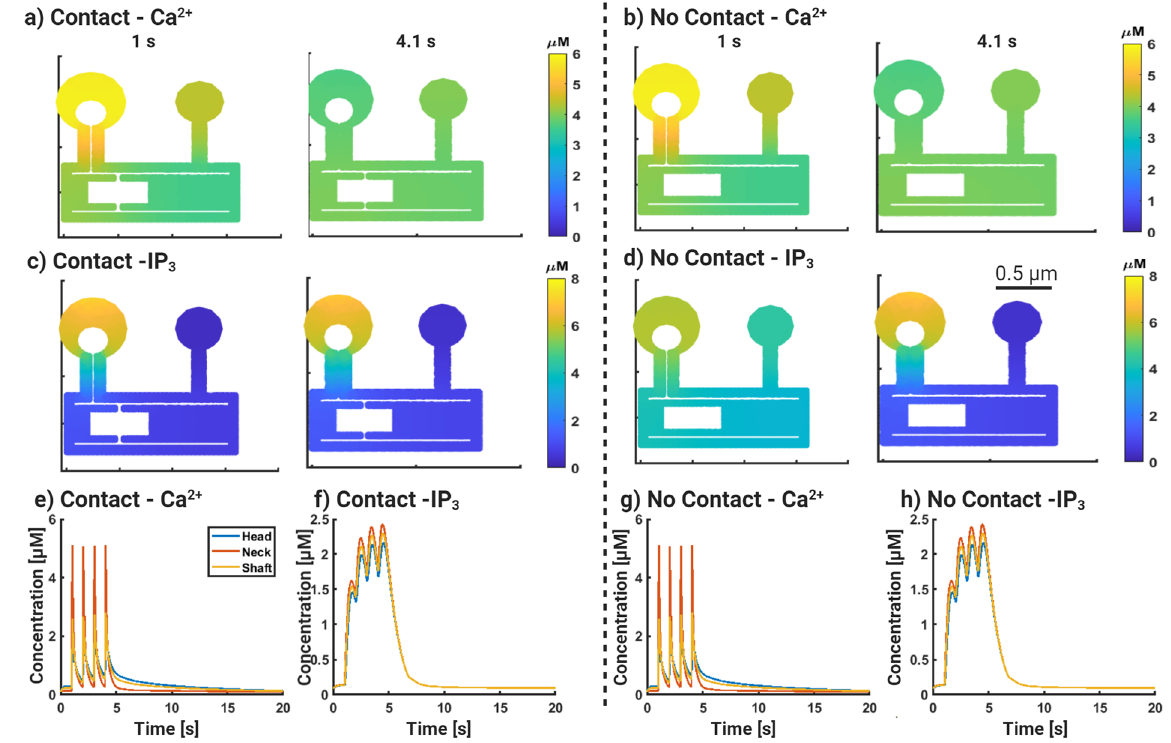
Fig. 2 Receptor-based simulations of glutamatergic signaling in spatial calcium model. Finite element simulations of dendritic spines including mitochondria, ER, and mitochondrial-ER contacts(MERC). a ) Ca 2 + dynamics in the stimulated and neighboring spine in the presence of MERC. b ) Same as ( a ) in the absence of MERC. c ) IP 3 dynamics in the stimulated and neighboring spine in the presence of MERC. d ) Same as ( c ) in the absence of MERC. Time course of Ca 2 + ( e ) and IP 3 ( f ) with MERC. Time course of Ca 2 + ( g ) and IP 3 ( h ) without